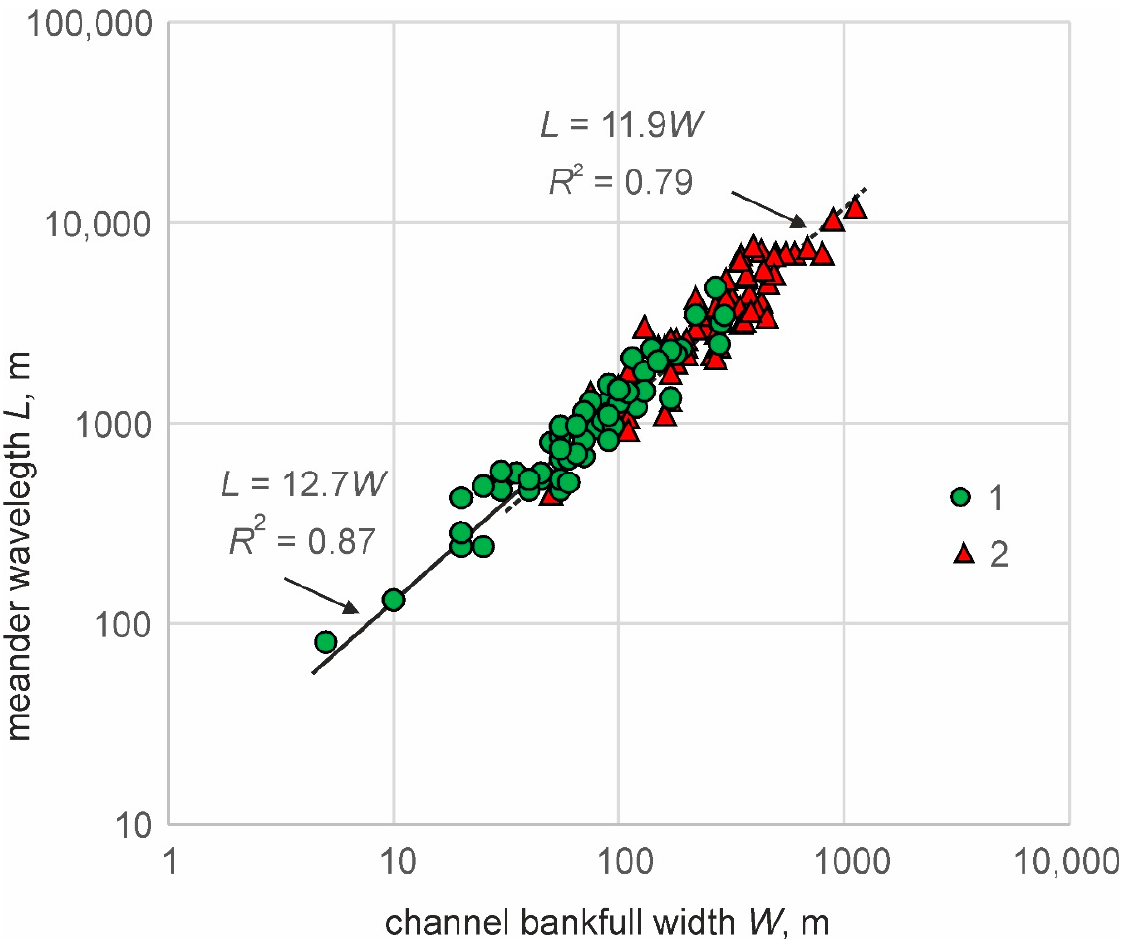
Figure 2. The relationship between the channel widths and meander wavelengths for the modern channels (1) and large paleochannels (2) in West Siberia. The data were adopted from [25] with corrections.